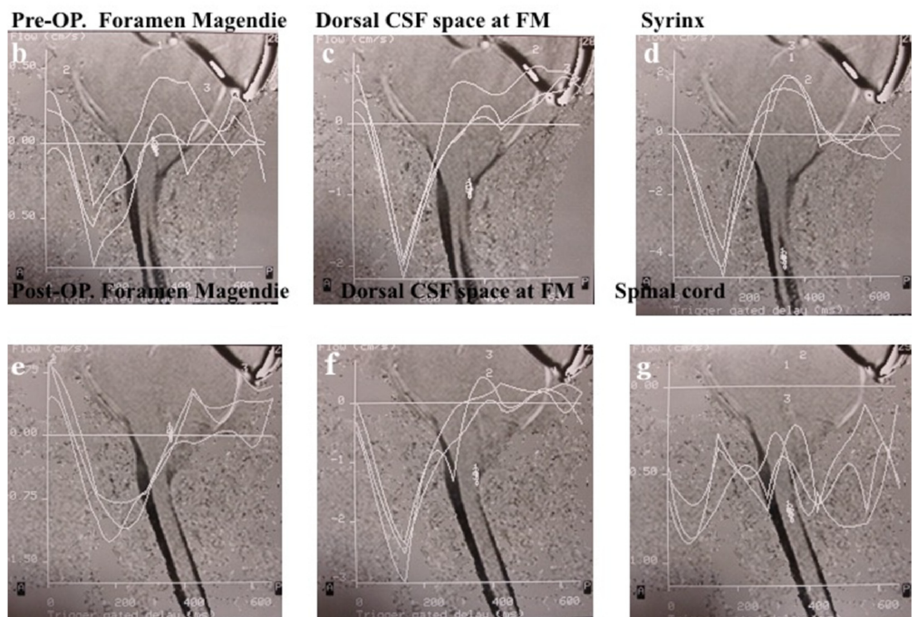
Figure 5. Measurement of maximum flow velocity (cm/s) and % cardiac cycle in Cine PC MRI, and pre- and post-operative illustrative cases. ( a ): Photograph showing the methods used for measuring percentage cardiac cycle (time of maximum flow velocity from R wave: A/R-R interval: B) and maximum flow velocity (speed of maximum flow: C) on cine phase contrast MRI. ( b – f ): Cine phase contrast MR images demonstrating that the caudal maximum flow velocity at the foramen of Magendie and dorsal CSF space at the foramen magnum (FM) is smaller than in controls and increased post-operatively. ( d , g ): Cine phase contrast MR images demonstrating large caudal maximum flow velocity in the syringomyelia; however, reliable post-operative flow was not